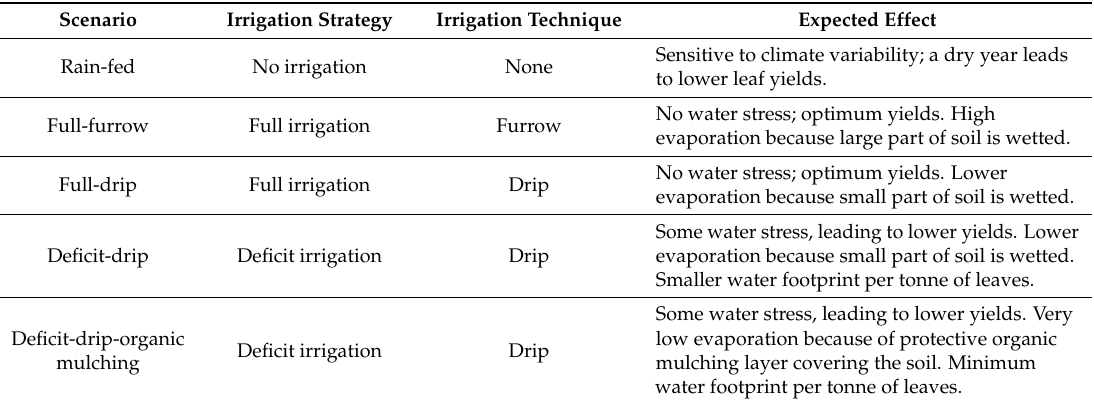
Table 1. Different scenarios of cultivating mulberry shrubs evaluated in this